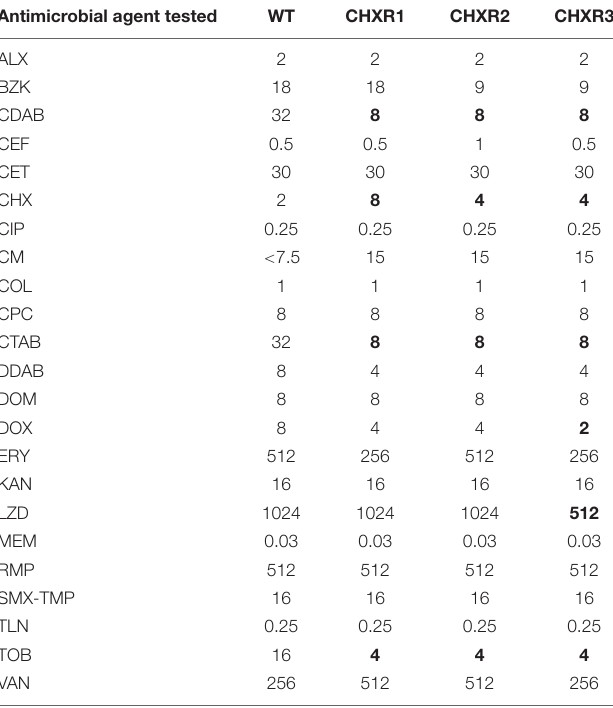
Bold values indicate > 2-fold differences in MIC as compared to WT. ALX, alexidine dihydrochloride; BZK, benzalkonium chloride; CAZ, ceftazidime; CDAB,